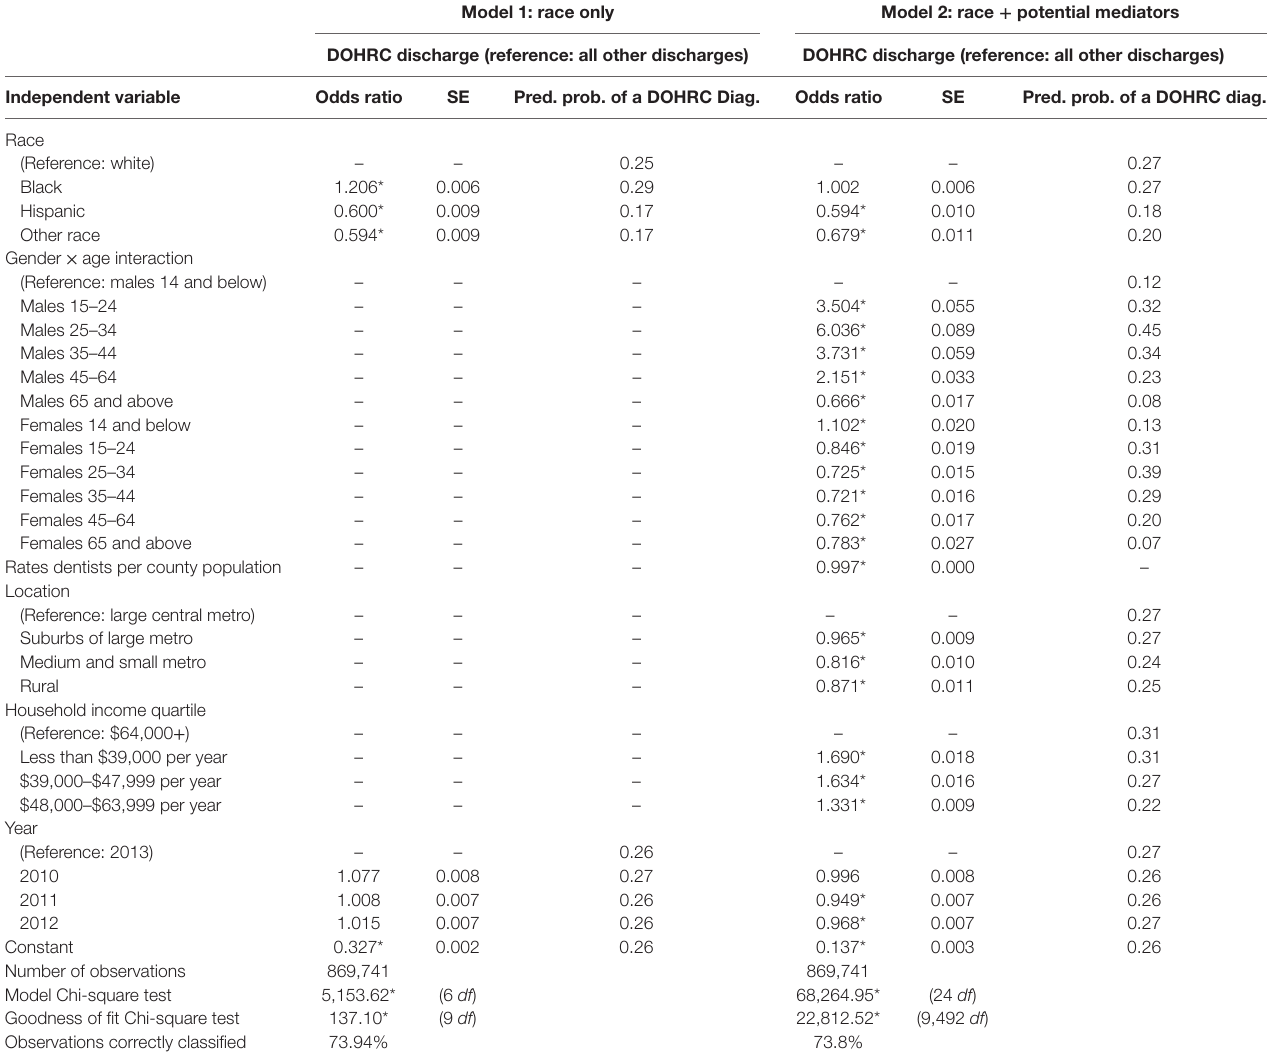
Table 2 | Fixed effects logistic regression model estimating dental/oral health-related condition (DOHRC) discharges in Maryland using State Emergency Department Data (SEDD) 2010–2013. Model 1: race only Model 2: race + potential